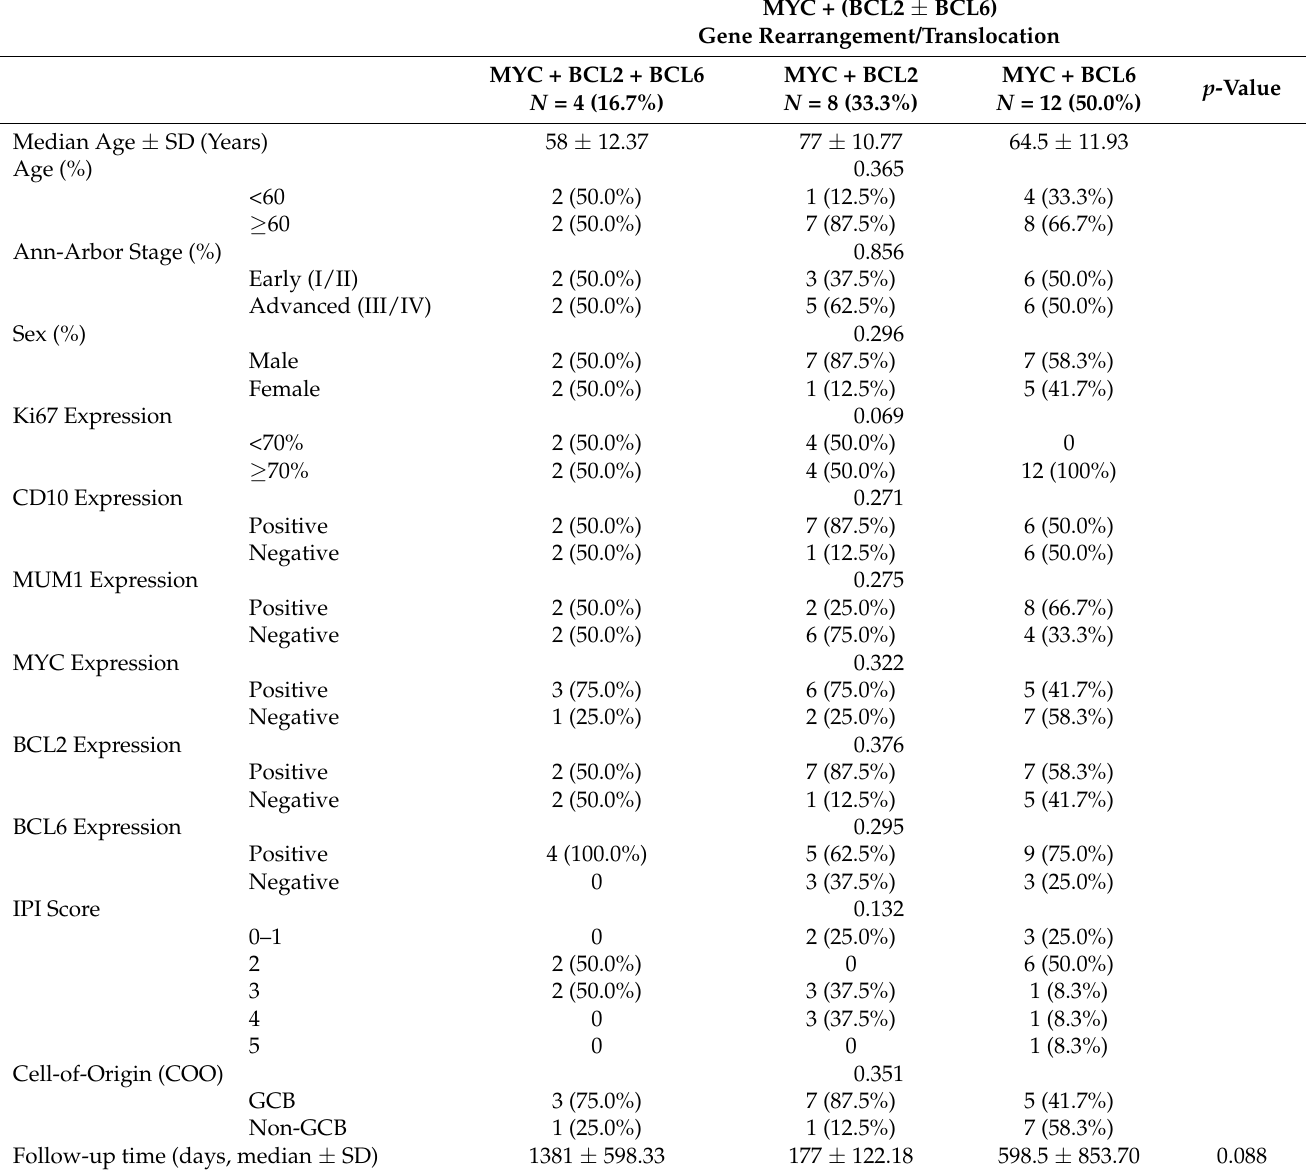
Table 2. MYC , BCL2 and BCL6 rearrangement-stratified clinicopathological characteristics of our DLBCL cohort ( n = 282) based on the presence or absence of gene